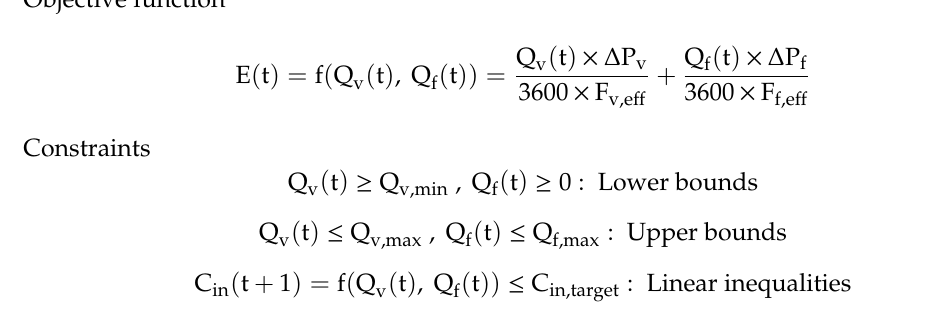
Figure 1. Goals of optimal ventilation and filtration control.